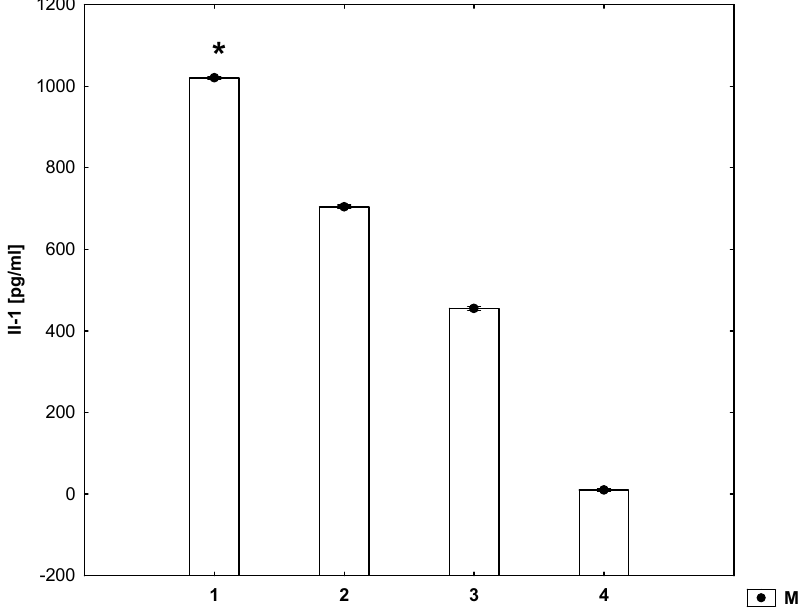
Figure 1. Concentrations of Il-1 β in the cell culture supernatant (ANOVA). 1—cell suspension + mitogen + homocysteine, 2—cell suspension + mitogen, 3—cell suspension, 4—medium. * statistically significant difference compared to every other group for p ≤ 0.05.